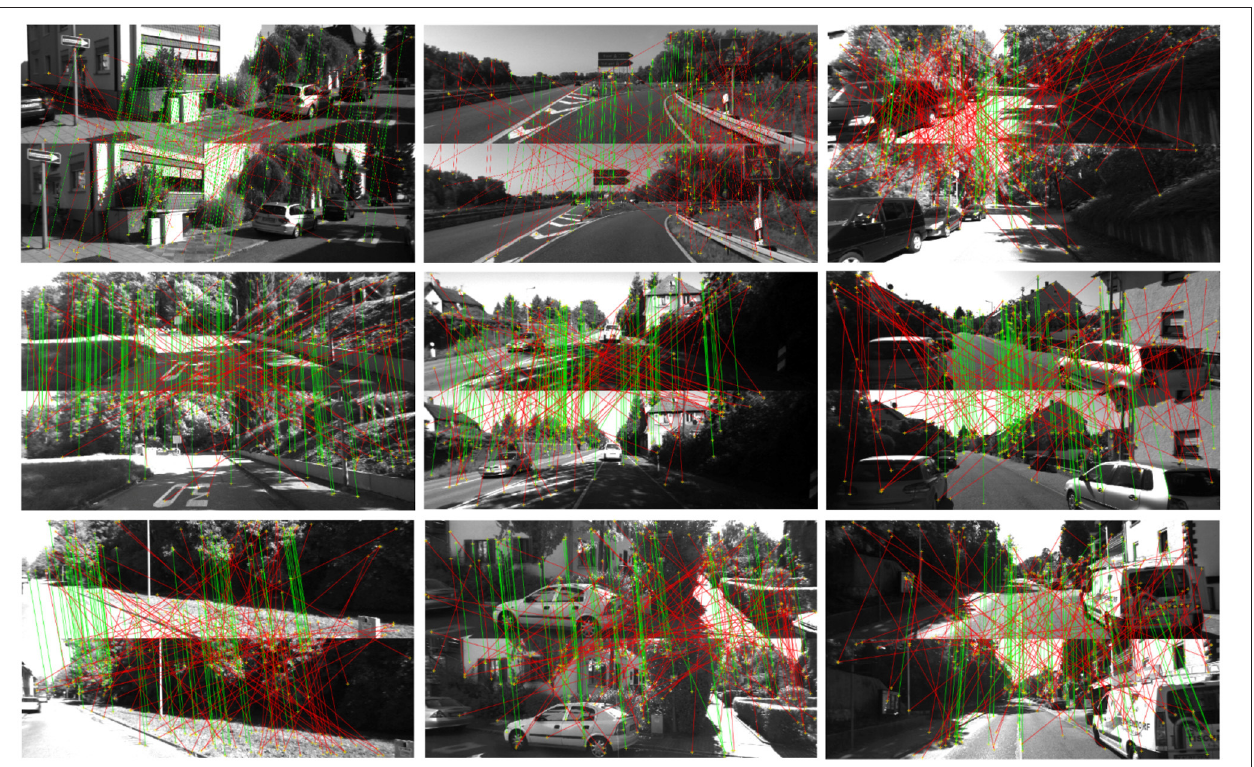
Frontiers in Neurorobotics |